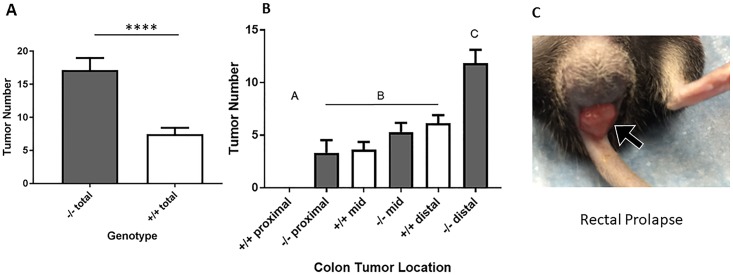
Histograms of tumor number (A) and gross distribution (B), along with rectal prolapse (C).Statistical confirmation of the dramatic effect of Hltf-deletion on the total number of tumors (A) and on the spatial distribution of tumors (B) is consistent with the complete protrusion of the rectum through the anal canal beyond the anus (C). Values in panels A and B are mean ± SEM. Values with the same letter designation in panel B are not significantly different.